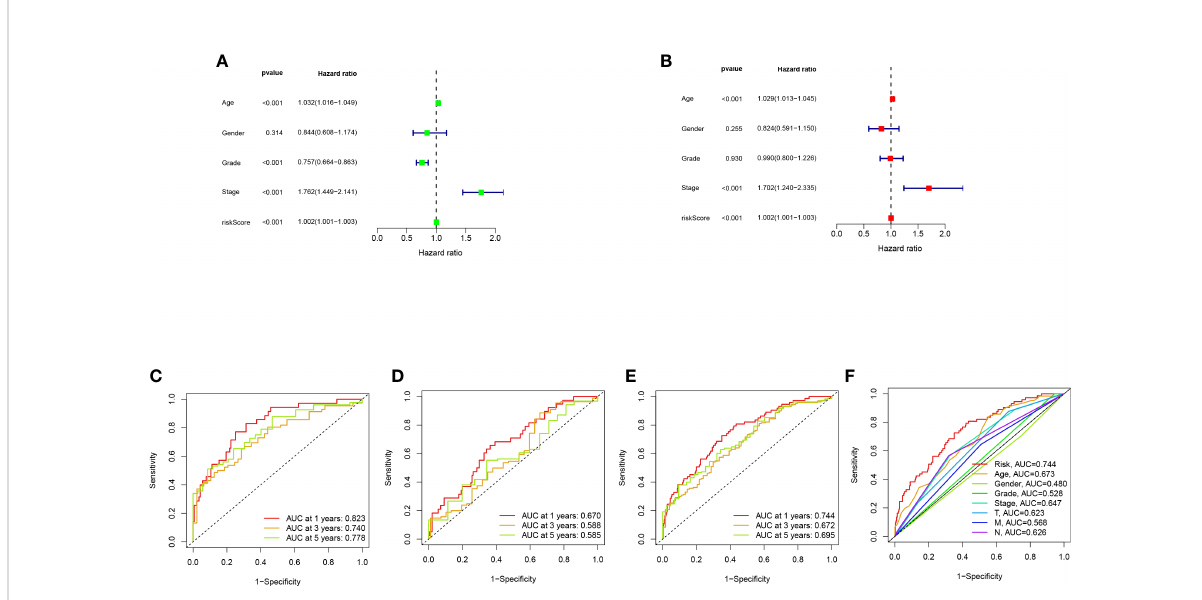
FIGURE 4 Validation of model assessment: (A) Uni- and multi-Cox analyses of clinical features; (C-E) 1-, 3-, and 5-year ROC curves of train, test, and entire sets; (F) ROC curves of risk scores and other clinical